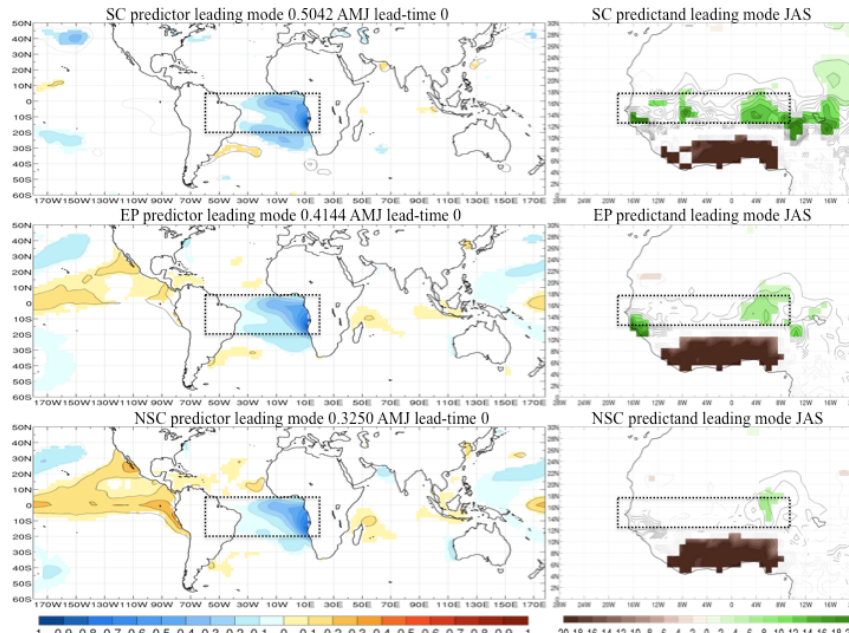
Figure 4. Regression maps obtained for the leading mode by applying MCA between SSTA in the tropical Atlantic (predictor) and western Sahel rainfall (predictand). Left column represents the homogeneous regression map done by projecting the expansion coefficient U onto global SSTA ( ◦ C). Right column represents the heterogeneous regression map done by projecting expansion coefficient U onto the anomalous Sahelian rainfall (mmday − 1 ). Period SC (top panels), EP (middle panels) and NSC (bottom panels). Rectangles show the selected regions for predictor and predictand fields considered in the MCA analysis. Values are plotted in regions where statistical significance under a Monte Carlo test is higher than